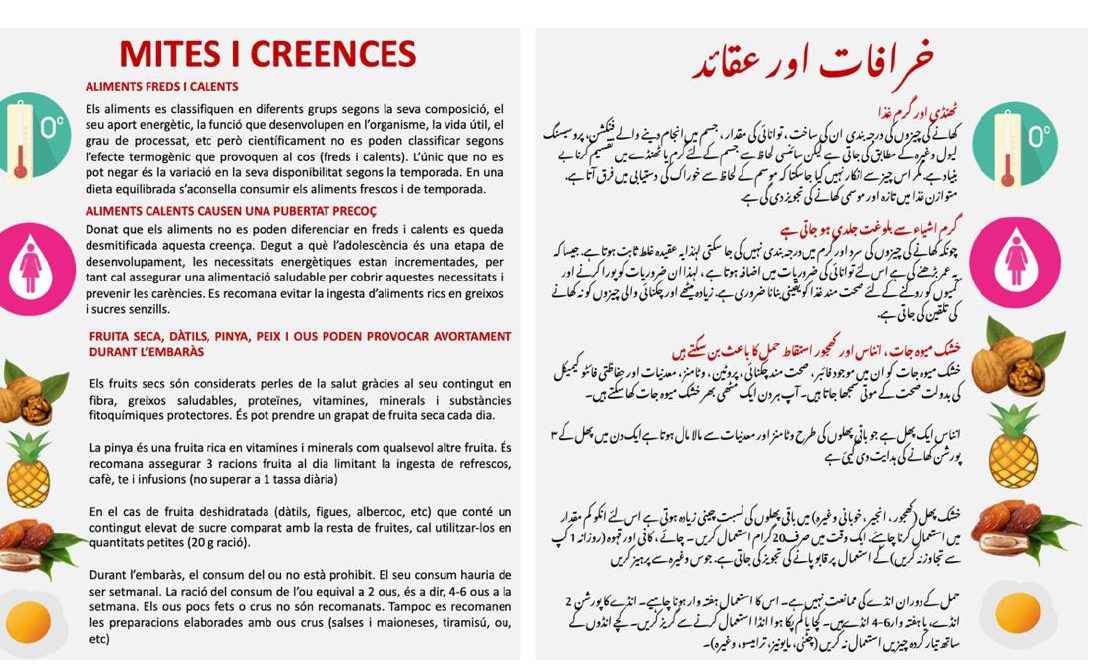
Figure 1. Infographic on myths and beliefs related to food.